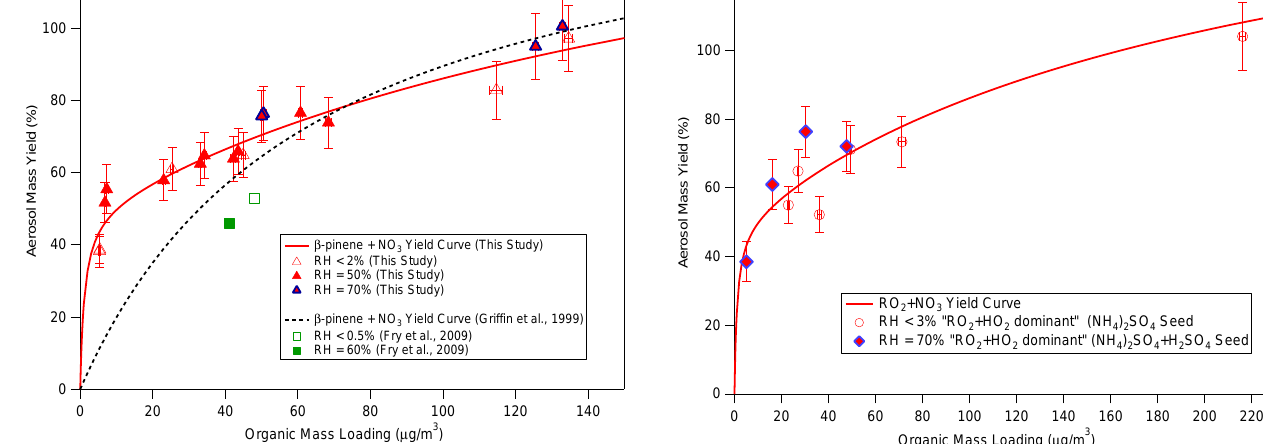
Figure 4. Aerosol mass yield as a function of organic mass loading for the β -pinene + NO 3 reaction under “RO 2 + HO 2 dominant” con- ditions. These aerosol mass yields are compared to the yield curve (solid line) for the NO 3 + β -pinene reaction under “RO 2 + NO 3 dominant” conditions. The x axis error bars represent 1 standard deviation of volume measured by SMPS at peak growth. The y axis error bars represent uncertainty in yield calculated by an 8% uncer- tainty in chamber volume, 5% uncertainty in hydrocarbon injection, and 1 standard deviation of the aerosol volume measured by SMPS at peak